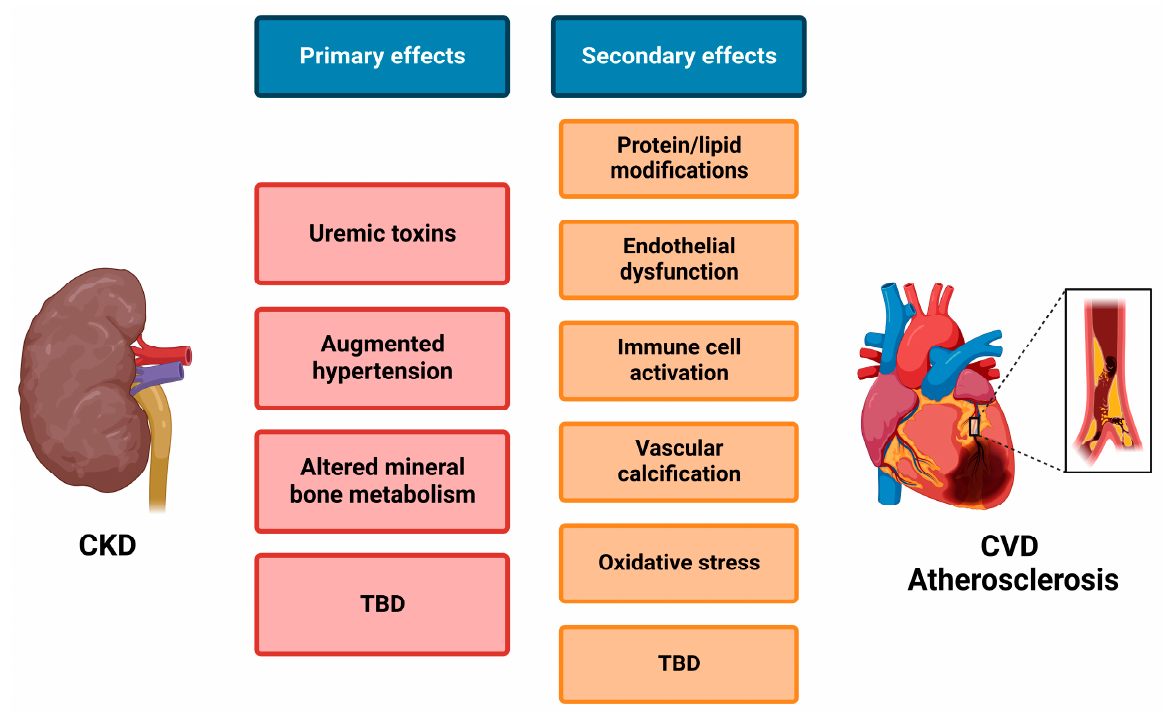
Figure 3. Simplified overview of mechanisms involved in cardiorenal cross-talk. Upon kidney damage and development of chronic kidney disease (CKD), several primary effects occur that can either directly or via subsequent secondary effects influence atherosclerosis and thus cardiovascular disease (CVD). Although several mechanisms are already known, many more remain to be defined (TBD). Created with BioRender.com.